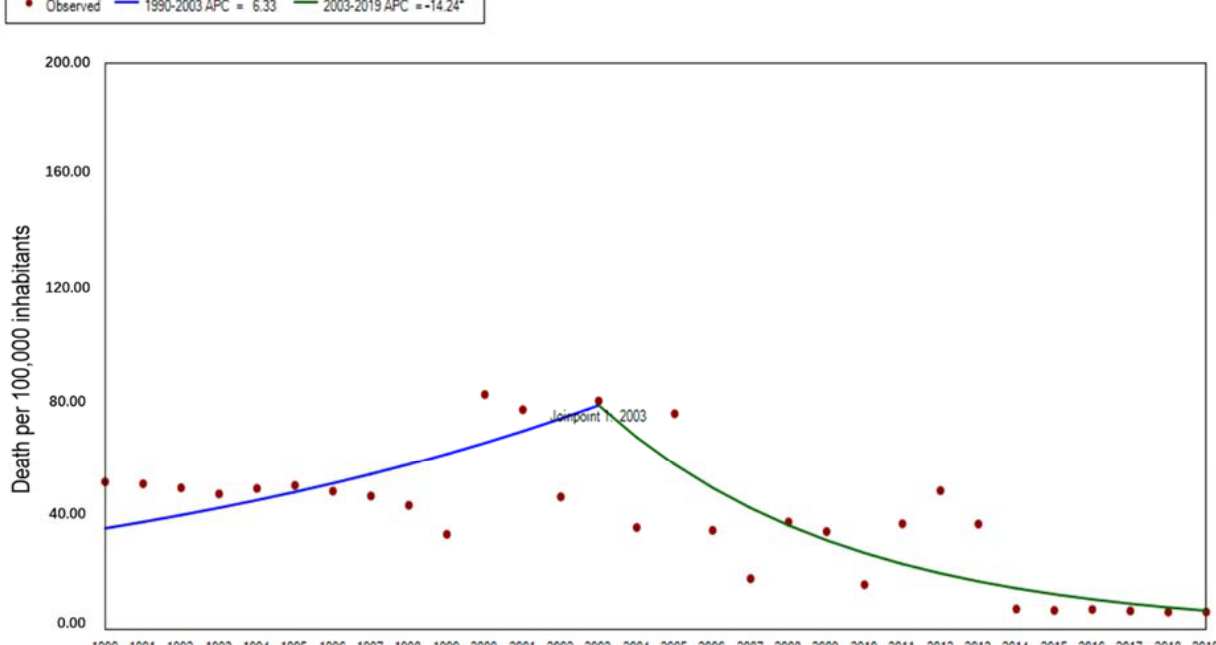
Figure 1. The trend of age-standardized incidence rates for malaria in STP, 1990–2019. Note: * indicates p < 0.05.